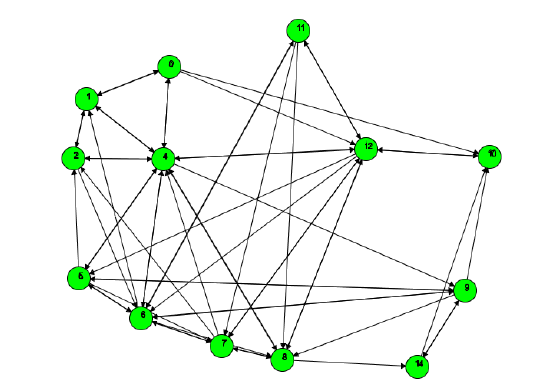
Figure 4: The graph structure generated from the extracted places and the segmented trajectories.